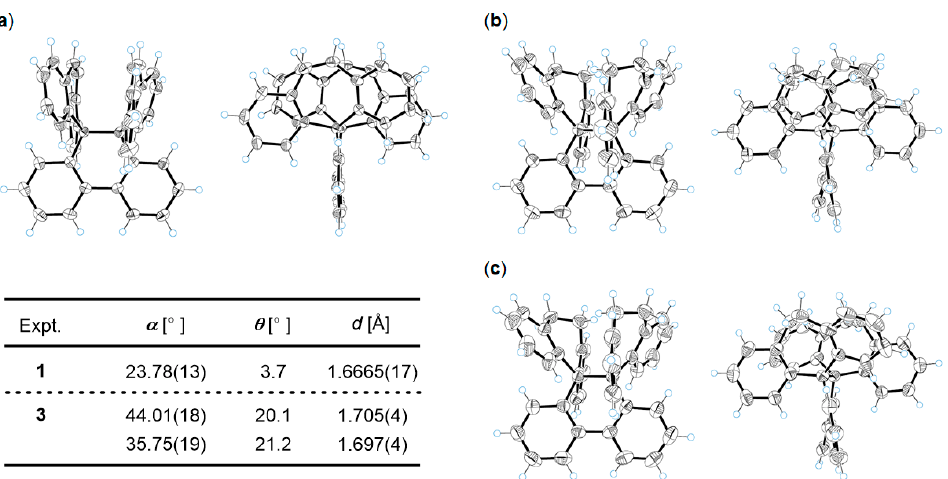
Figure 6. ORTEP drawings (left: front view, right: side view) of ( a ) 1 ; ( b ) 3 (mol-1) and ( c ) 3 (mol-2) at 150 K. Thermal ellipsoids are shown at the 50% probability level.